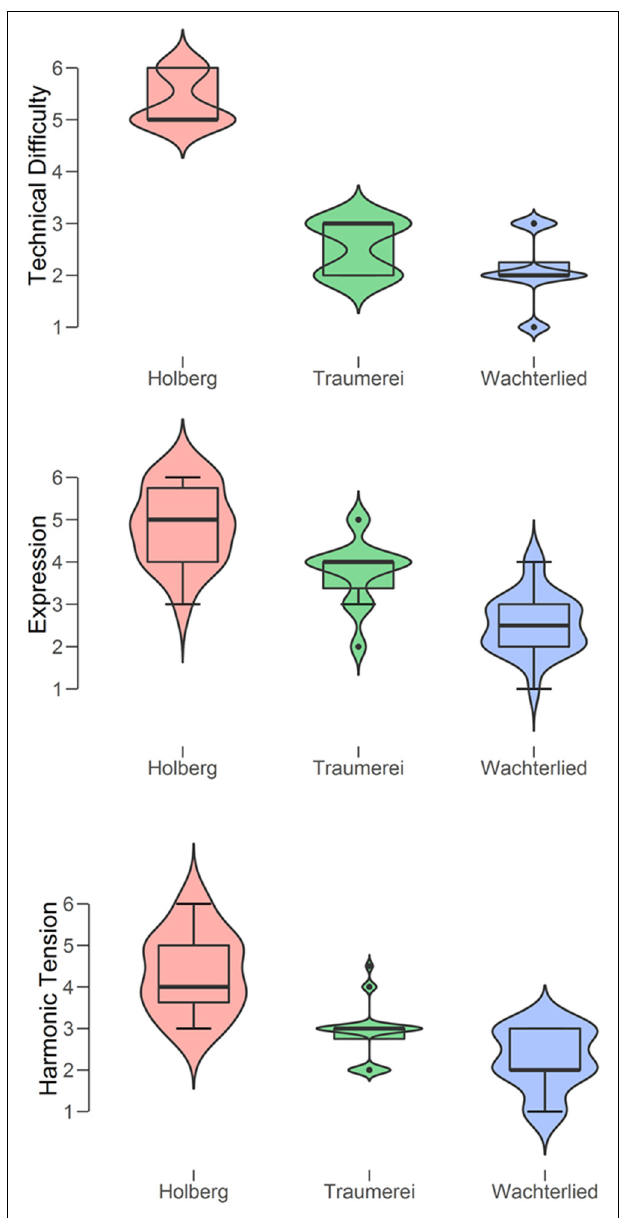
FIGURE 2 | Violin boxplots of the ratings by the Professional Pianist of the three types of difficulty (from top to bottom: technical, expressive, and harmonic tension) for each of the three piano pieces (Holberg Suite, Träumerei, and Wächterlied).